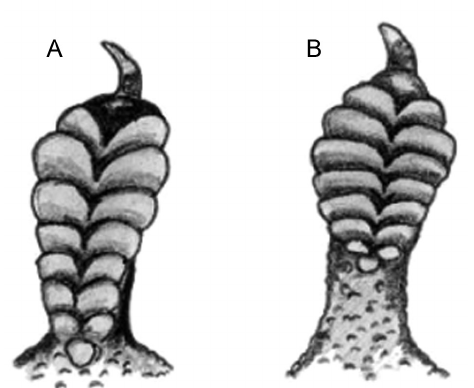
Figure 3. Morphological differences of subdigital lamellae of digit IV within Hemidactylus . A. Subdigital lamellae extending to the base (as in H. angulatus , H. frenatus , and H. garnotii ). B. Subdigital lamellae not extending to the base ( H. mabouia ). Figure taken and adapted from Krysko and Daniels (2005: fig.